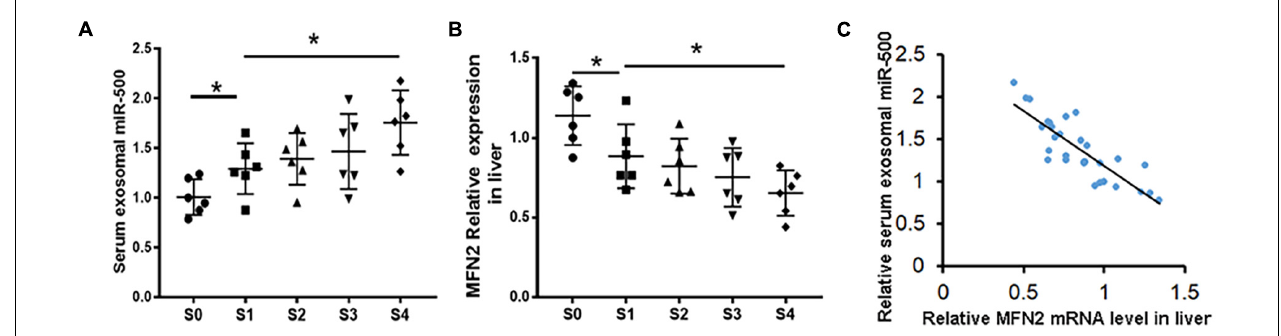
FIGURE 7 | miR-500 in serum exosomes might be a potential biomarker for the development of liver fibrosis. (A) Relative expression of miR-500 in serum exosomes isolated from CHD patients including S0 ( n = 6), S1 ( n = 6), S2 ( n = 6), S3 ( n = 6), and S4 ( n = 6). (B) The expression levels of MFN2 in liver tissues of CHD patients in different stages of liver fibrosis were detected by qRT-PCR. (C) Correlation analysis of exosomal miR-500 in serum and MFN2 in human liver tissues. Data are represented as mean ± SD of three replicates. * P < 0.05.